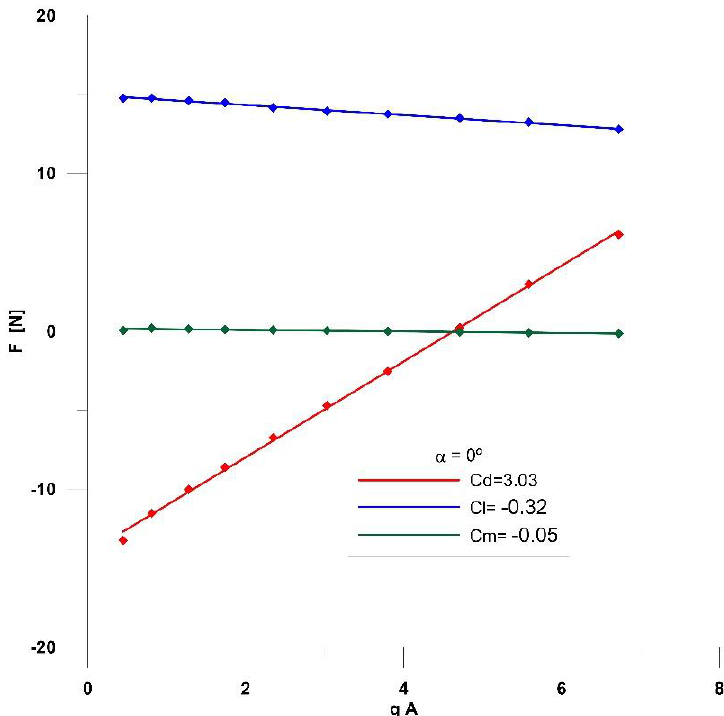
Figure 7. Evaluation of aerodynamic coefficients for α = 0 º.